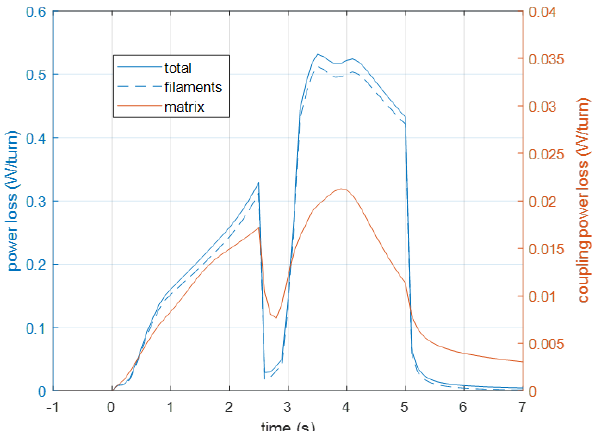
Figure 11. Total power in the bottom-most turn during the operating cycle. Two different scales are used for the filament and the matrix